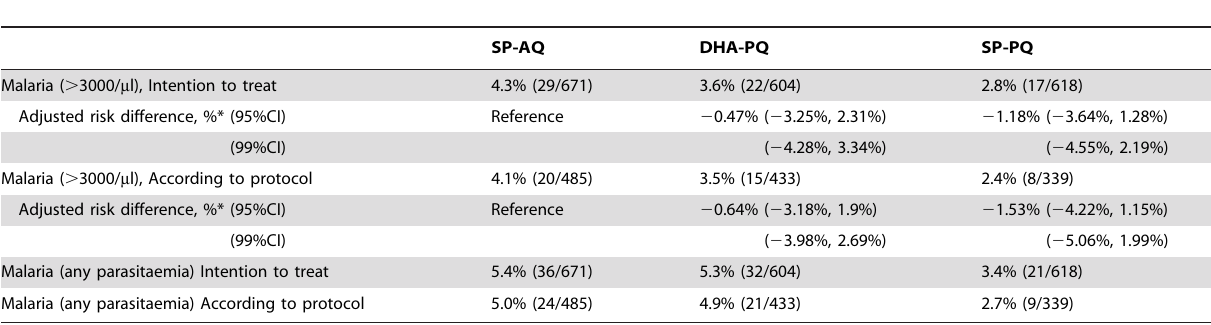
Table 3. Cumulative incidence of malaria during the study